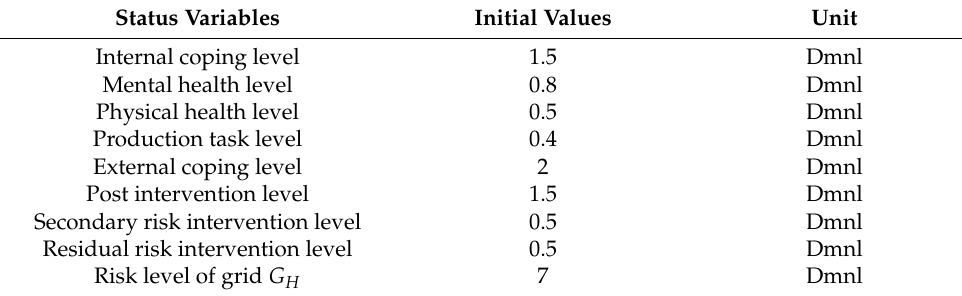
Table 7. Initial values of the state variables of grid G H